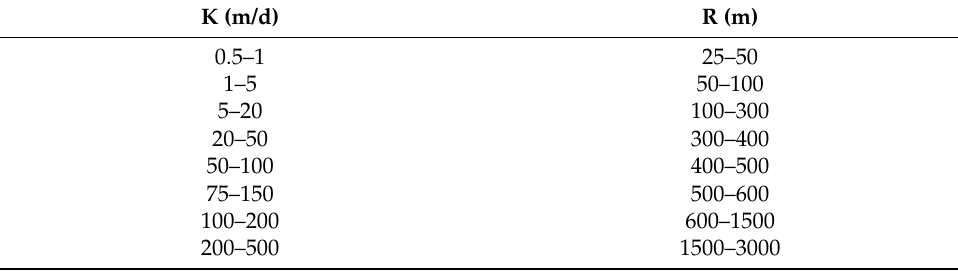
Table 3. Empirical relationship of K and